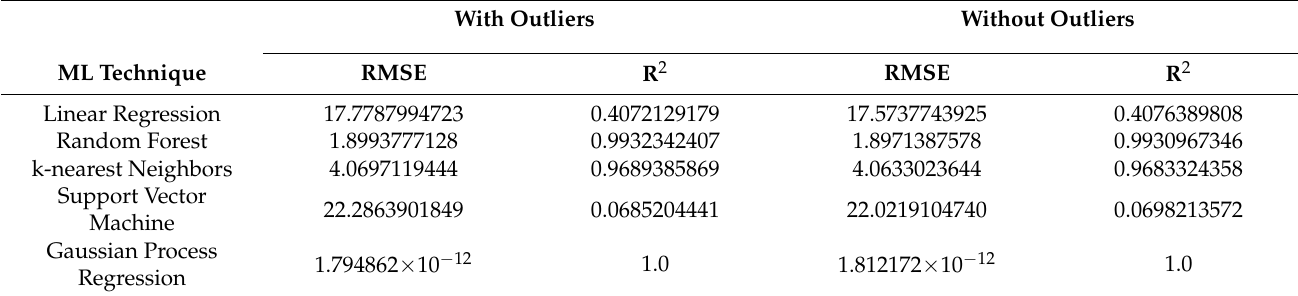
Table 8. O 3 results.